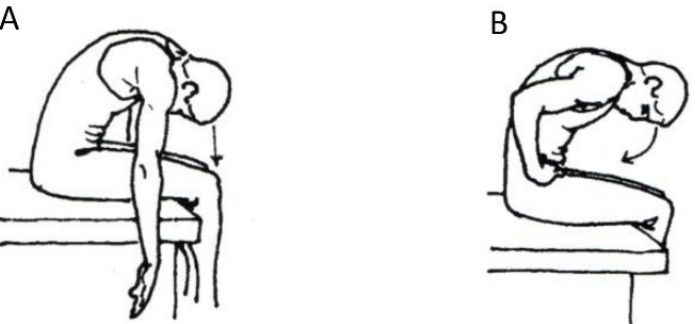
Figure 1. ( A ) Mobility test of the trunk with flexion of the head and pelvic tilt (rotation), and ( B ) without the pelvis tilted forward.